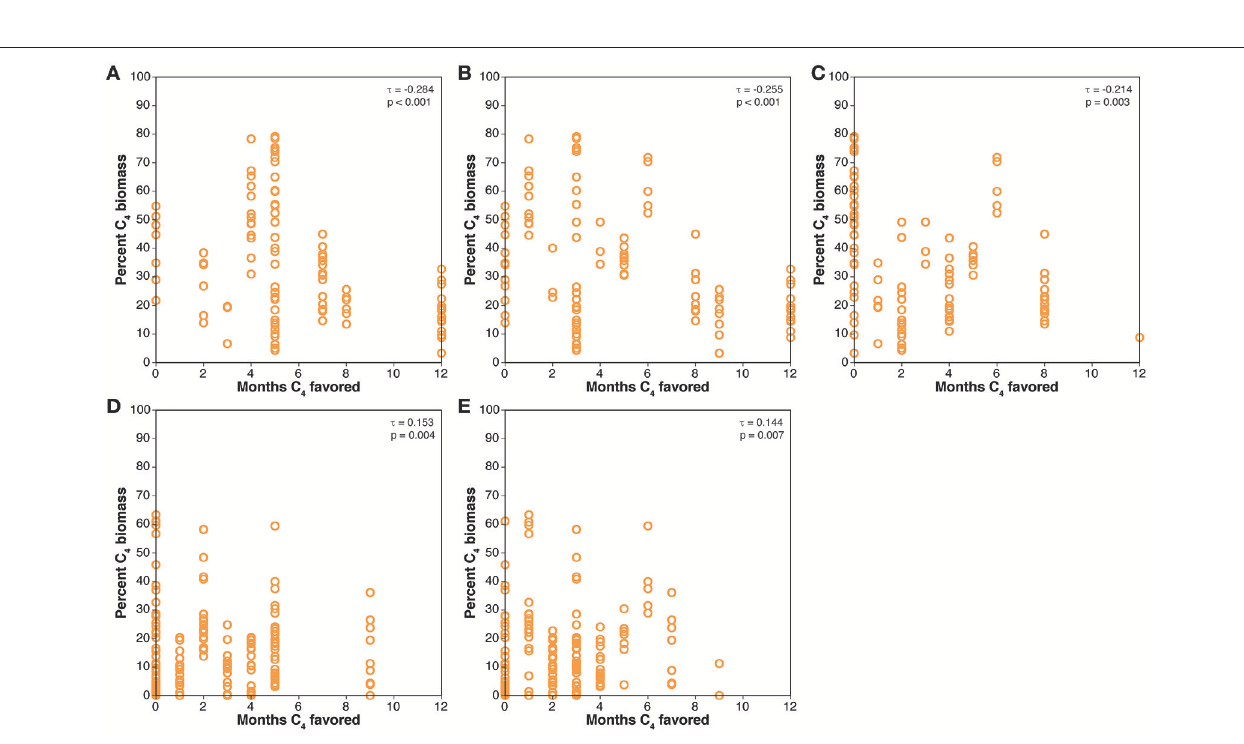
Frontiers in Ecology and Evolution | www.frontiersin.org